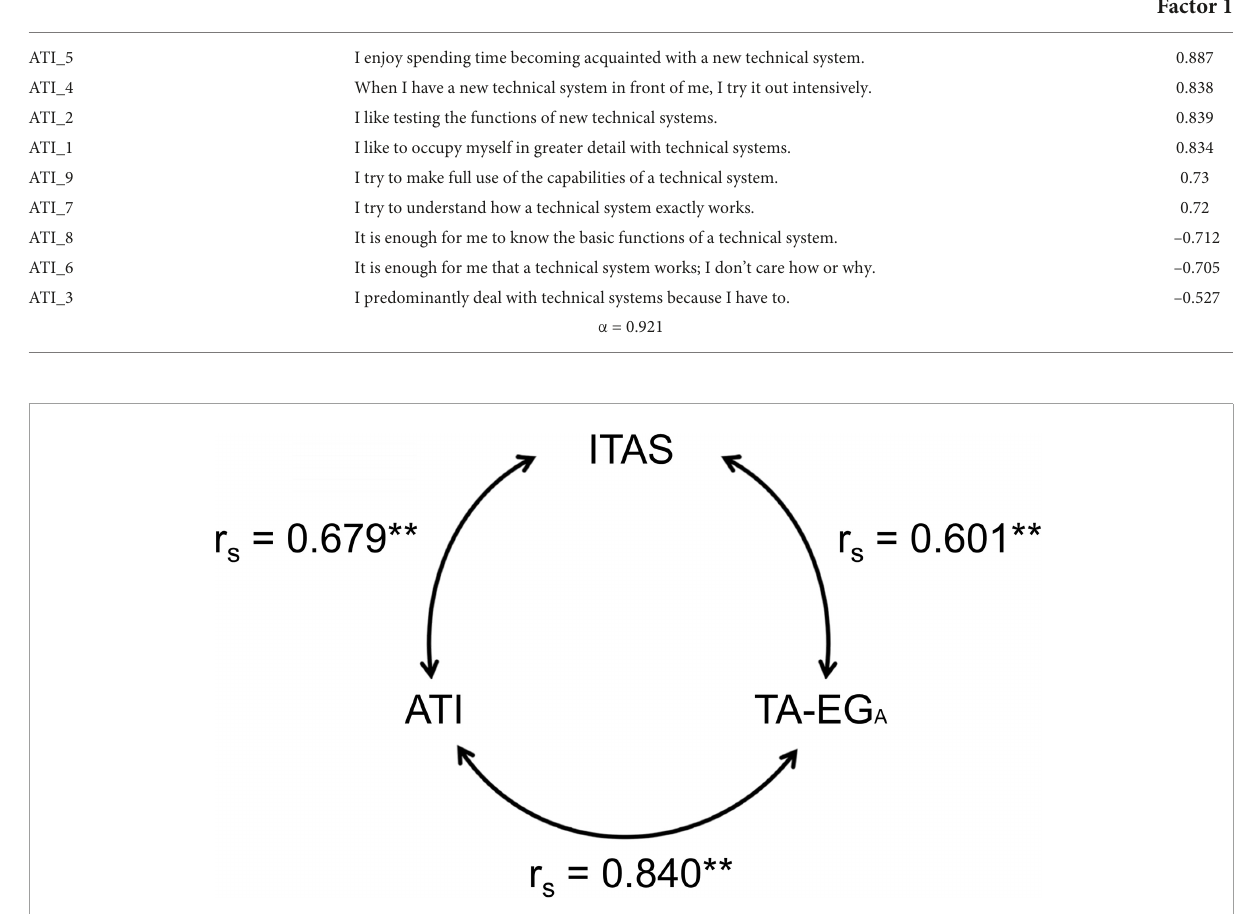
FIGURE3 Correlations according to Spearman’s rank correlation (r s ) between the technology affinity scales (ATI; TA-EG A ; ITAS) used in study 1. **Significant at the level p < 0.01.